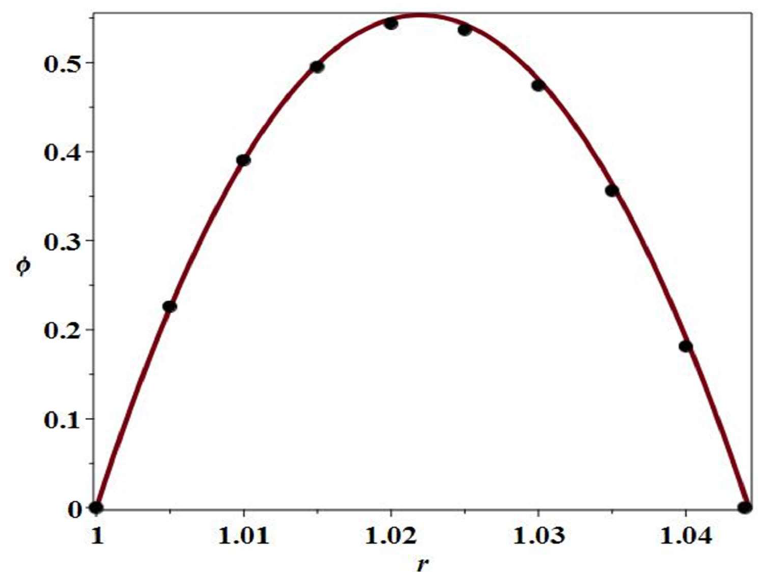
Figure 2. Stream function ϕ (r , θ = π /2 ) for Ra = 100 and R = 2 1/16 obtained analytically (continuous line) and using numerical direct simulation (black dots).